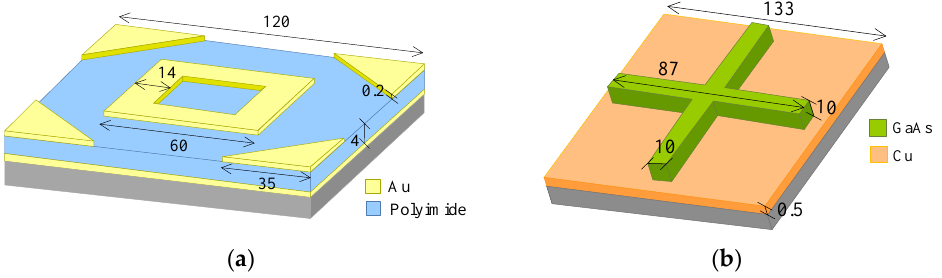
Figure 1. Unit cell of ( a ) SquarePMA and ( b ) CrossPMA with given dimensions in µm.